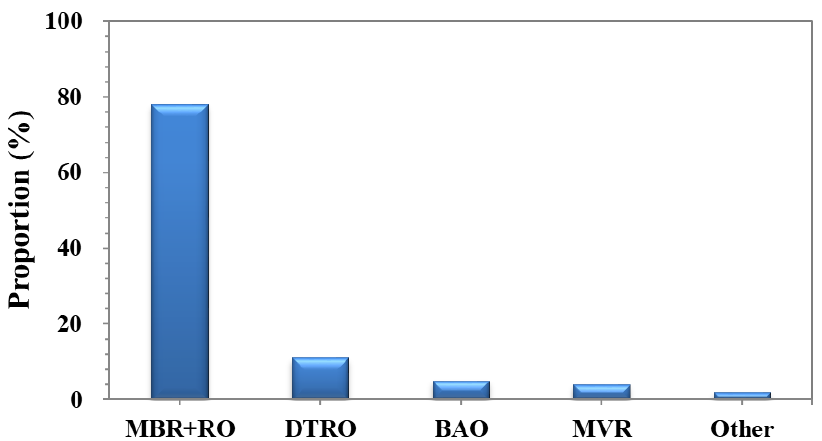
Figure 1. The proportion of main leachate treatment technologies. MBR + RO: membrane bioreactor + reverse osmosis; DTRO: two-stage disc tube reverse osmosis; BAO: biochemical + advanced oxidation; MVR: mechanical vapor recompression.